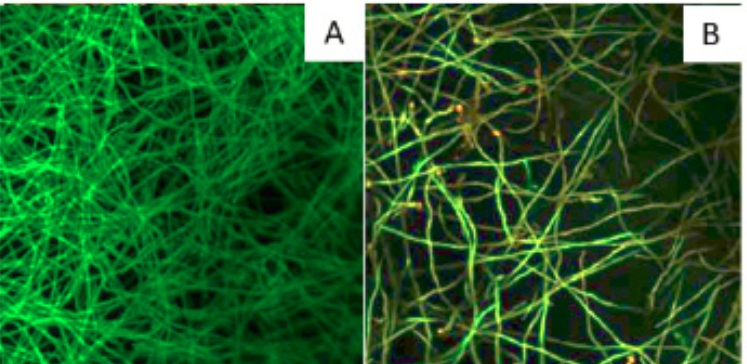
Figure 6. Impact of microgravity on biofilm density. Observation, using confocal microscopy, of the biofilm formed under 1 g control ( A ) and simulated microgravity ( B ) conditions after labeling with FUN-1 (intracellular labeling in red) and ConA (labeling of the cell wall in green) ( × 400). Example of biofilm formation by the CBS 124630 strain after 72 h of culture in the RPM or at 1 g.